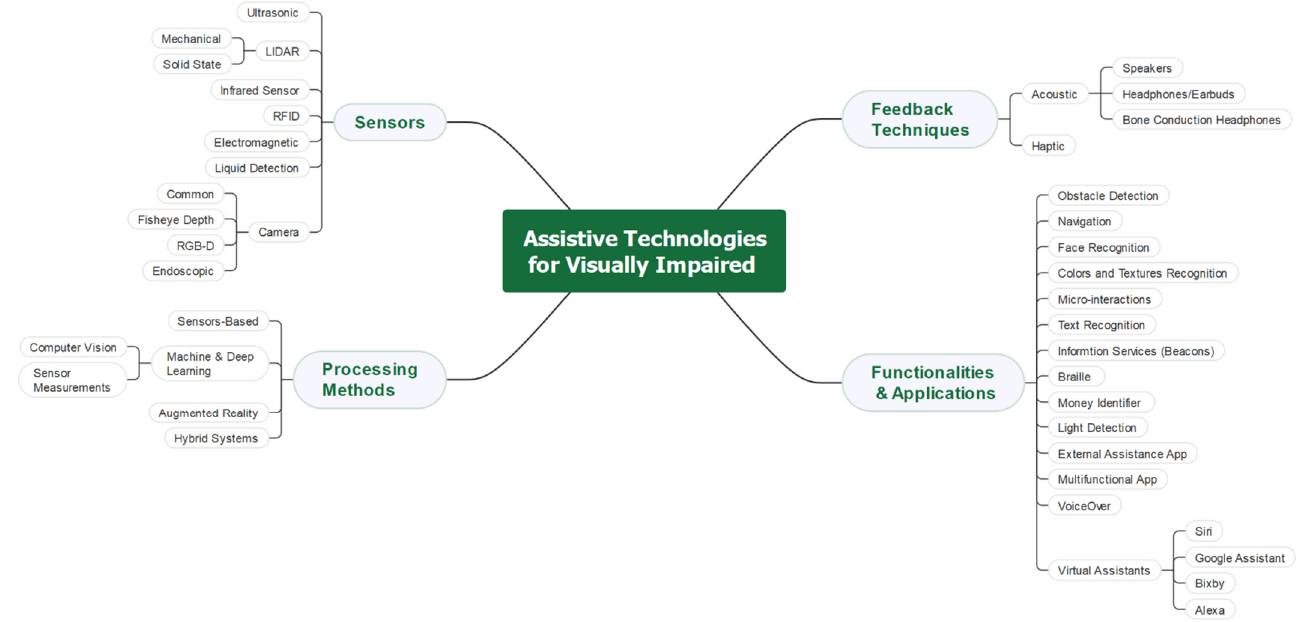
Figure 1. A Taxonomy of Research on Assistive Technologies for the Visually Impaired.